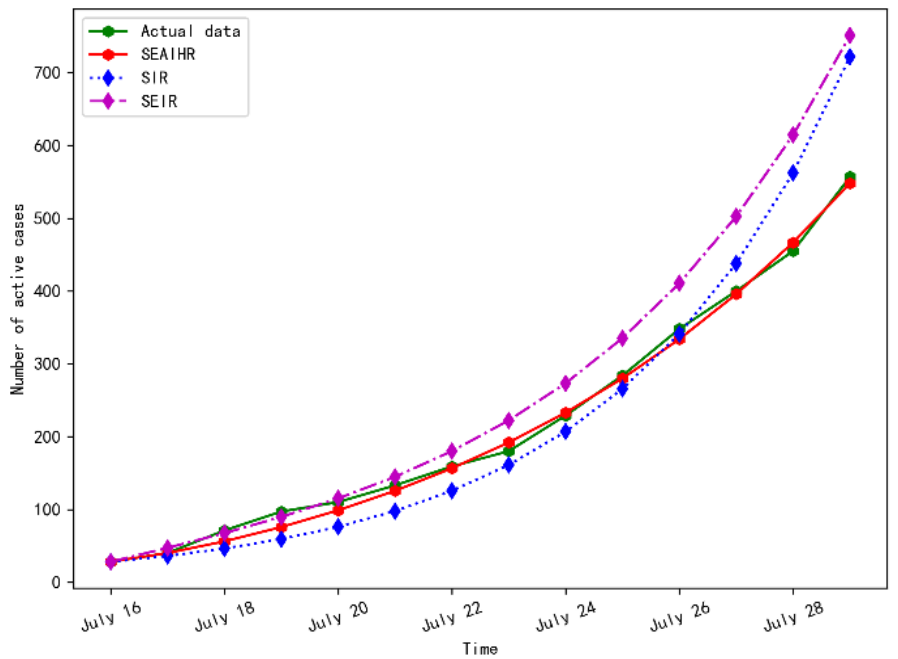
Figure 10. Simulation results comparison of different models.